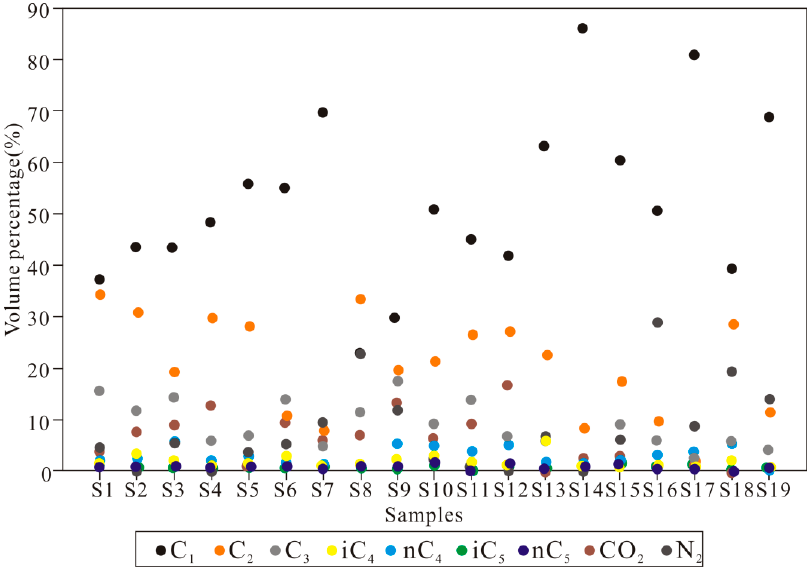
Figure 3. The volume percentage of different gas components. C 1 : methane; C 2: ethane; C 3 : propane; iC 4 : iso-butane; nC 4 : n-butane; iC 5 : iso-pentane; nC 5 : n-pentane; CO 2 : carbon dioxide; N 2 : nitrogen.